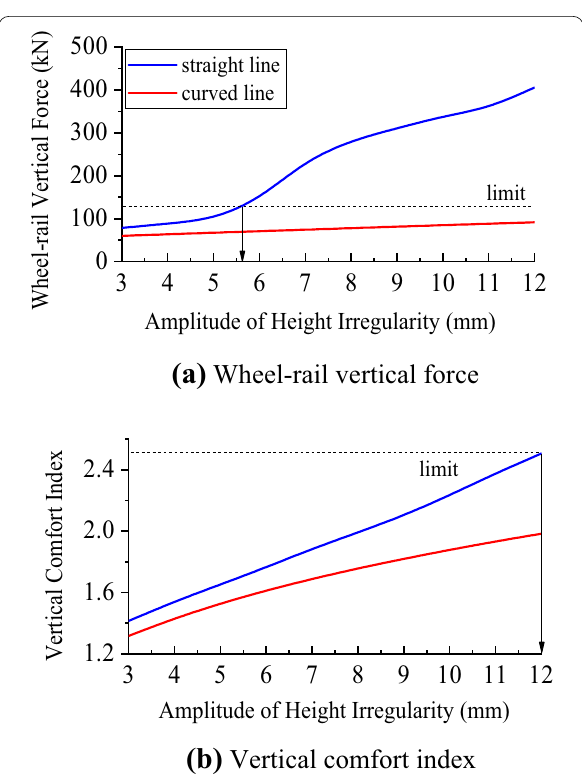
Figure 11 Influence of variation in height irregularity amplitude on wheel-rail vertical force and vertical comfort index under straight and curved operational line conditions